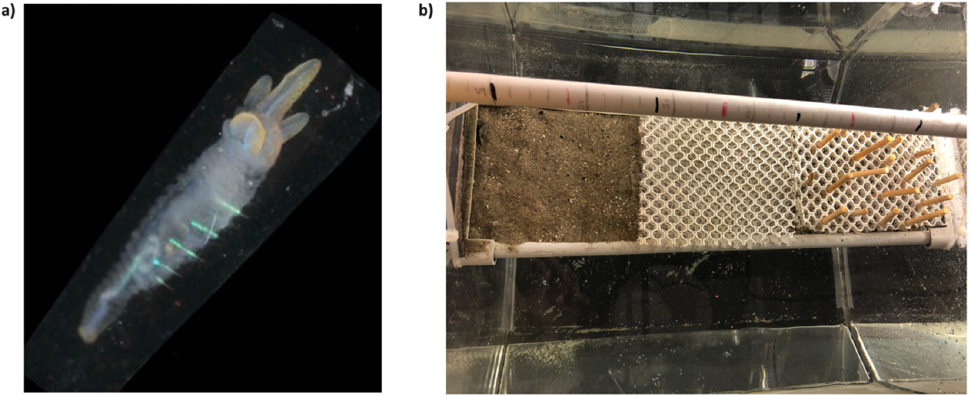
Figure 7. Larvae experiment. ( a ) L. conchilega aulophore; ( b ) organisation of the 3 substrates in the